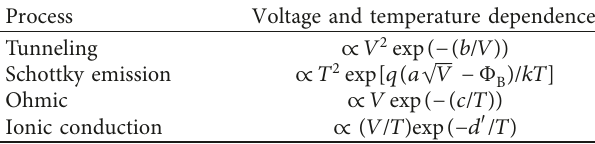
Table 1: Basic conduction process Process Voltage and temperature dependence